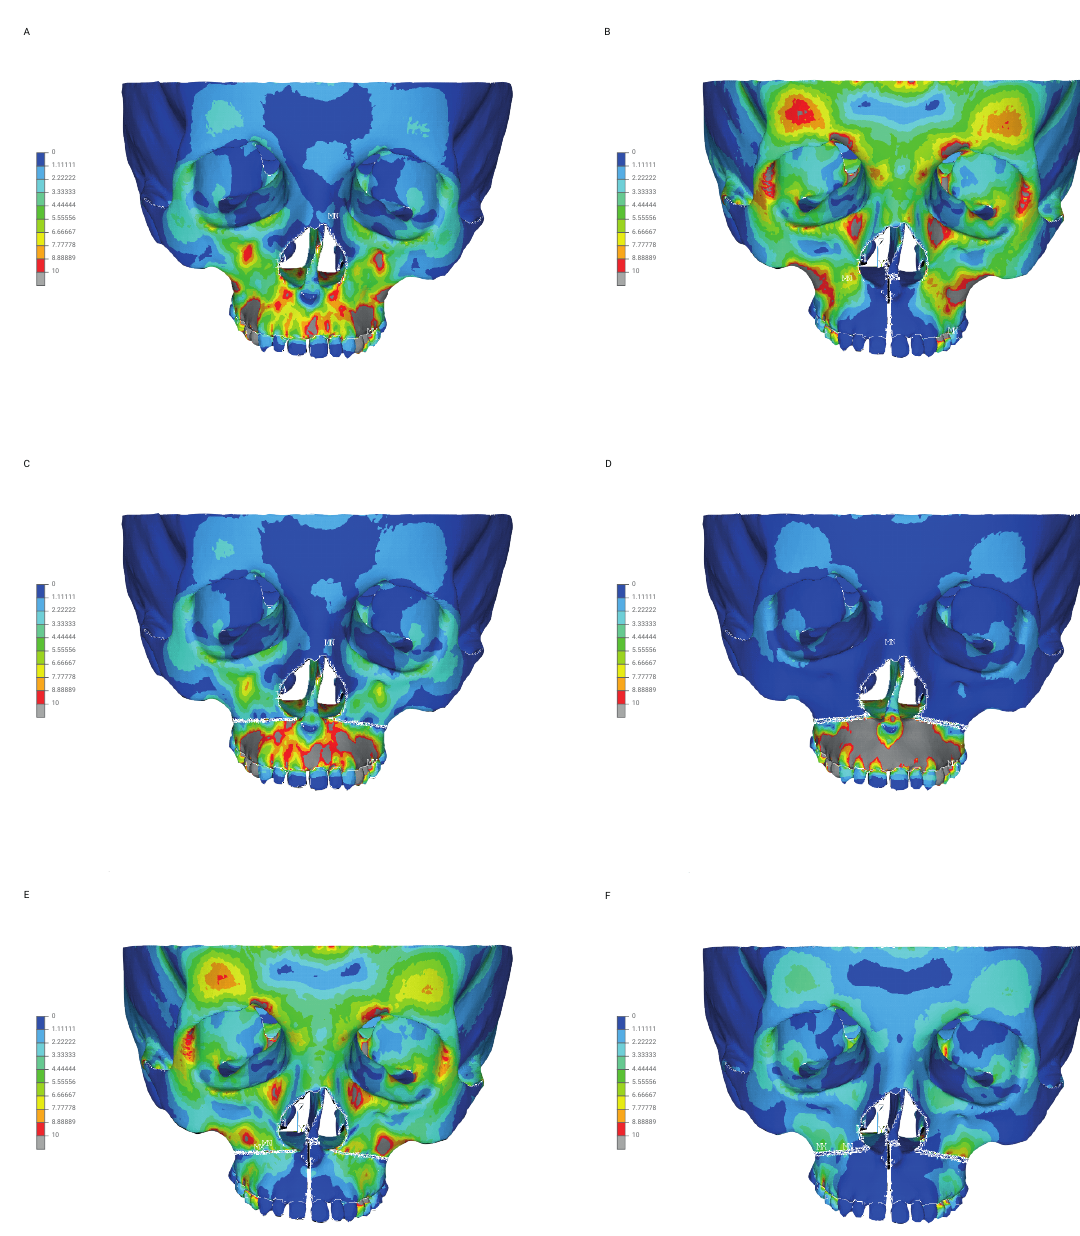
Figure 5. ( A – F ). The finite element model showing according to Huber stress distribution over craniofacial skeleton—front view (scale 0–10 MPa) caused by palatal expansion using five di ff erent surgical procedures and without osteotomy: ( A ) without osteotomy; ( B ) sagittal osteotomy; ( C ) transversal osteotomy modo Le Fort I without PMJ separation; ( D ). transversal osteotomy modo Le Fort I with PMJ separation; ( E ) sagittal osteotomy with transversal osteotomy modo Le Fort I without PMJ separation; ( F ) the model used for finite element analysis—sagittal osteotomy with transversal osteotomy modo Le Fort I with PMJ separation. PMJ—pterygomaxillary